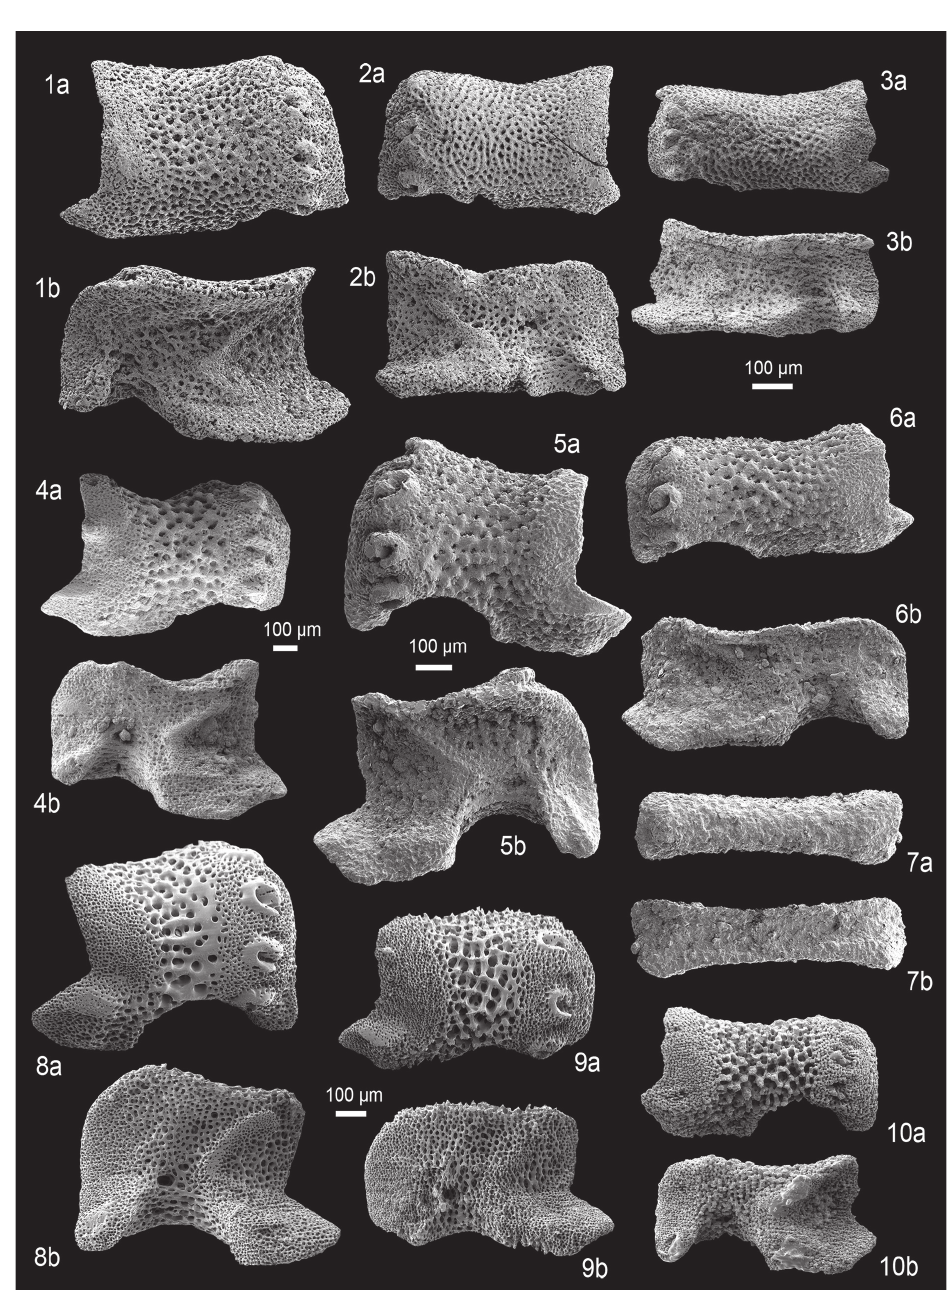
Fig. 10. Fossil lateral arm plates (LAPs) of ophiacanthid brittle stars in external (a) and internal (b) views. 1-3. Lapidaster lukenederi gen. et sp. nov. from the late Valanginian (Early Cretaceous) of the Ternberg Nappe, Austria. 1. NHMW 2012/0138/0001 (holotype), proximal LAP. 2. NHMW 2012/0138/0002 (paratype), median LAP. 3. NHMW 2012/0138/0003 (paratype), distal LAP. 4. Lapidaster sp. nov. innom. 2 from the early Kimmeridgian (Late Jurassic) of Geisingen, Germany; GZG.INV.78522, proximal to median LAP. 5-7. Lapidaster coreytaylori gen. et sp. nov. from the middle Aptian (Early Cretaceous) of Carniol, France. 5. GZG.INV.78523 (holotype), proximal LAP. 6. GZG.INV.78524 (paratype), median LAP. 7. GZG.INV.78525 (paratype), distal LAP. 8-10. Lapidaster mathcore gen. et sp. nov. from the middle Albian (Early Cretaceous) of Folkestone, Great Britain. 8. GZG.INV.78528 (holotype), proximal LAP. 9. GZG.INV.78529 (paratype), median LAP. 10. GZG.INV.78530 (paratype), distal LAP. One common scale bar per species is